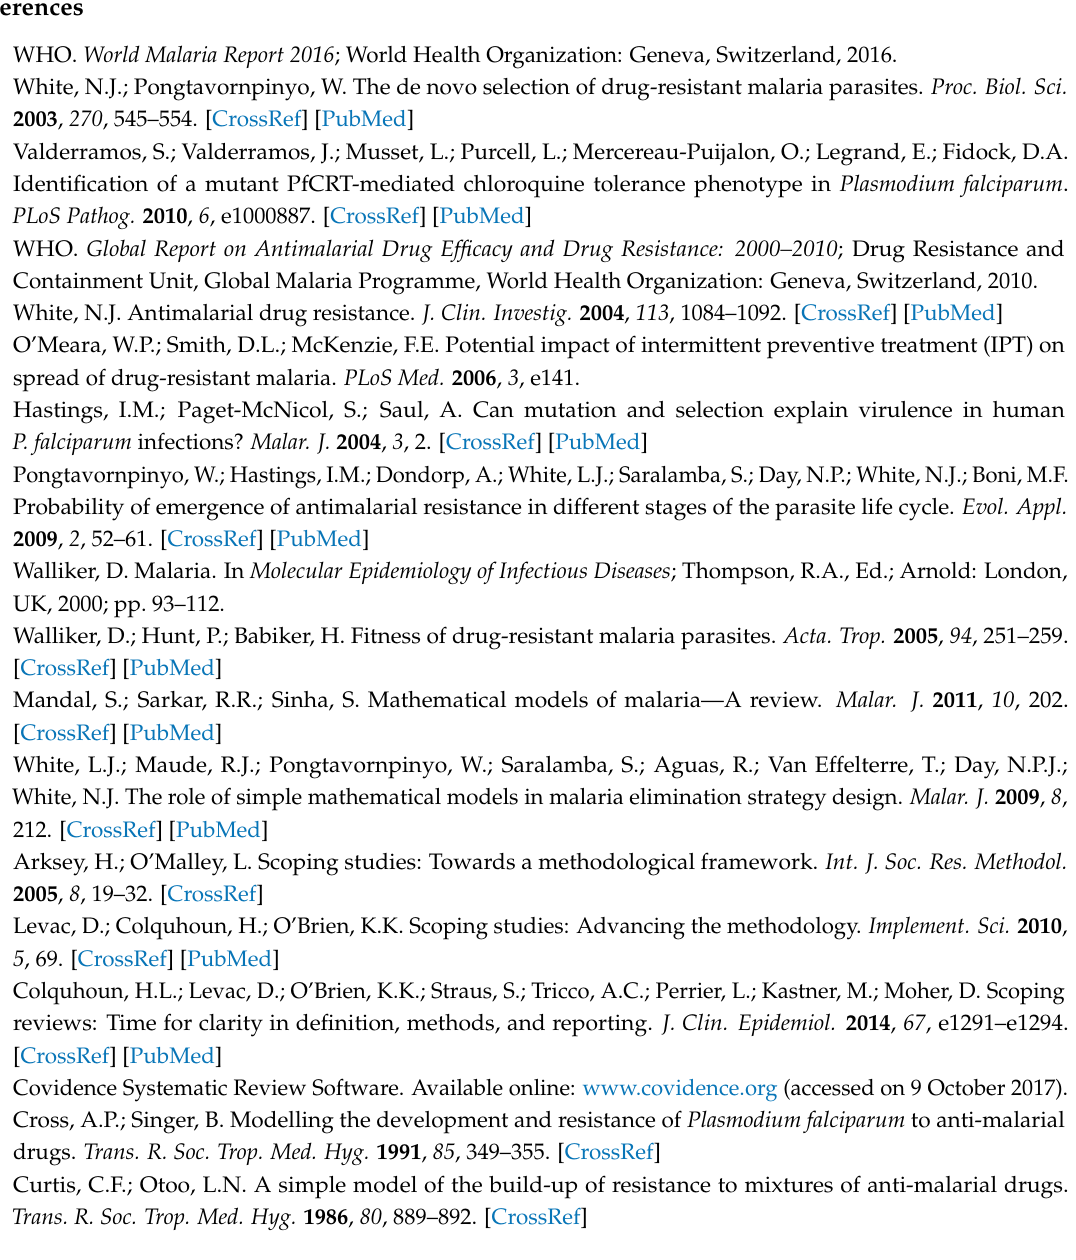
Table S1: Medline and Embase Database Search, Table S2: CINAHL Database Search, Table S3: Web of Science Database Search, Table S4: Cochrane Library Database Search, Table S5: Scopus Database Search, and Table S6: Grey Literature Search (Google Scholar and Open